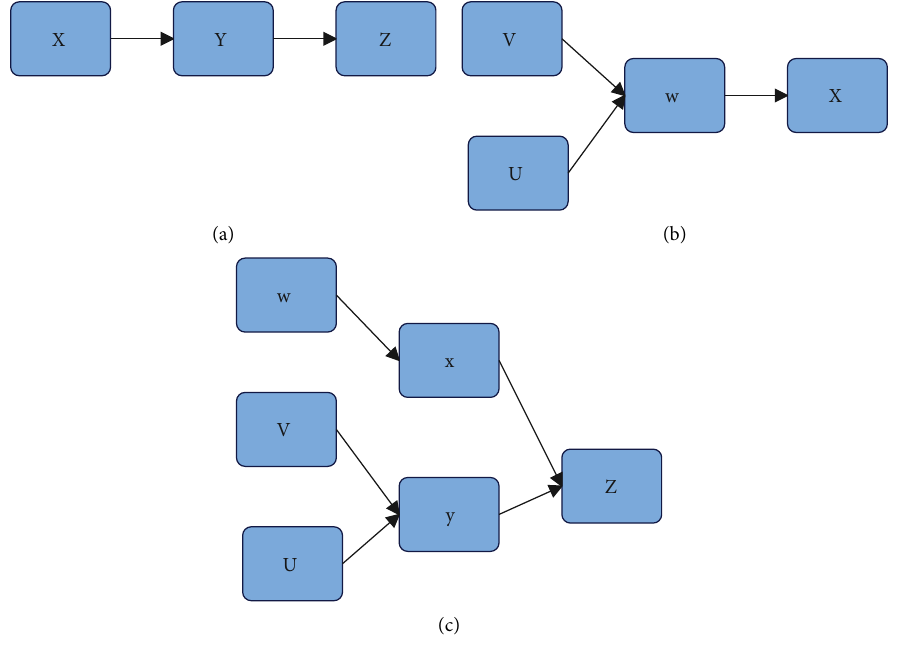
Figure 1: Directed acyclic